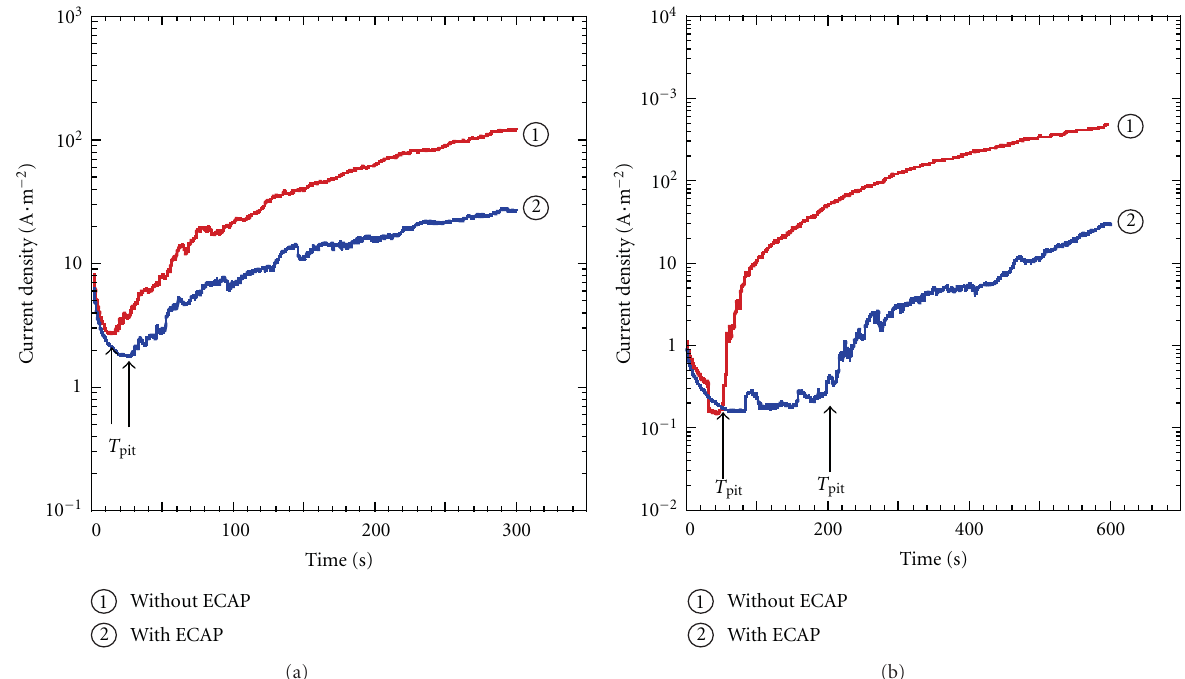
Figure 3: Time-dependence of the anodic current density of pure Al (a) and Al (AA1100) (b) while kept at constant potentials of, respectively, 0.3V and 0.2 V nobler than their pitting corrosion potential in a solution containing 0.1mol · dm − 3 of Na 2 SO 4 and 300 ppm of Cl − .